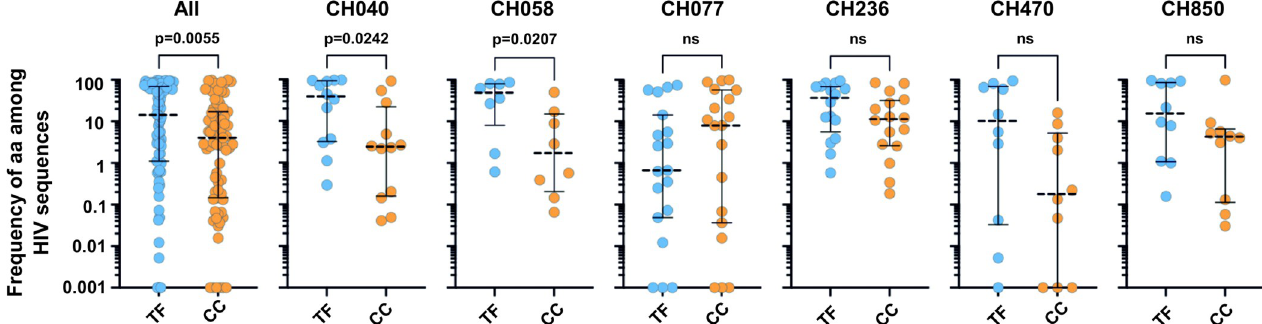
Fig 8. Transmitted HIV-1 tends to access more prevalent sequence space than matched chronic viruses. Amino acid substitution (or variation) frequencies for sites that exhibit amino acid divergence between the matched TF/CC pairs are shown using between 4568 sequences (Tat) and 19237 sequences (Nef) for subtype B and between 1548 sequences (Rev) and 4345 sequences (Env) for subtype C using sequences from the Los Alamos sequence database for each viral protein. Each point represents one of the amino acid sites that differs between the TF and CC in that virus pair. Medians and interquartile ranges are indicated and significance was determined using a Mann-Whitney